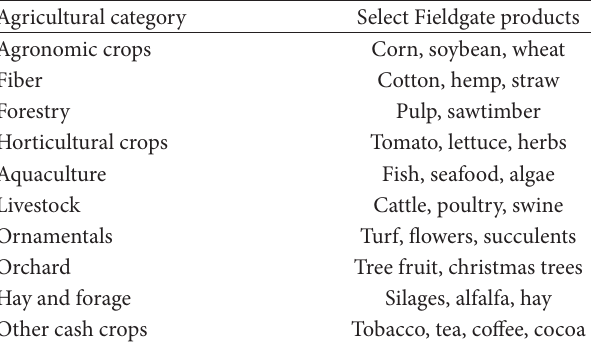
Table 1: Agricultural categories and associated Fieldgate